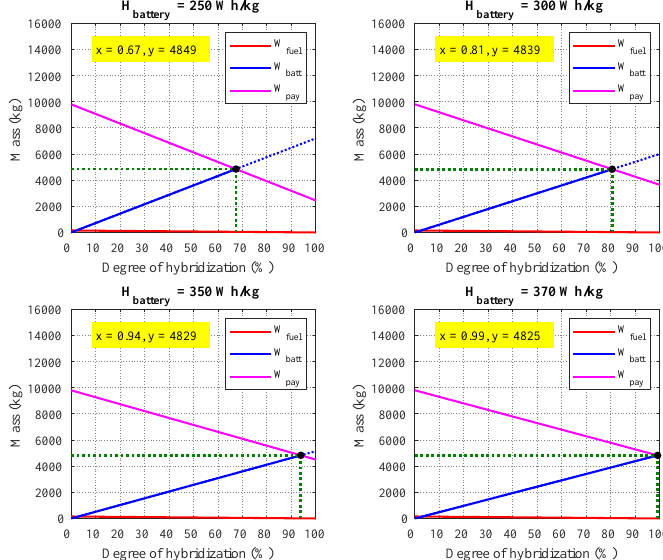
Figure 11. Effect of degree of hybridization on payload capability.